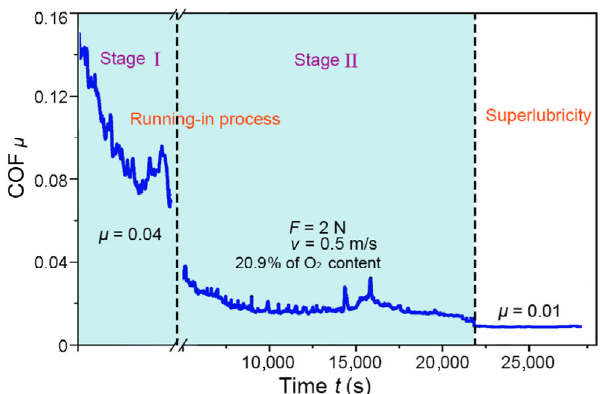
Fig. 1 COF (also denoted as μ ) vs. sliding time of the steel/steel interface lubricated with EPBD-0201 solution in a simulated air environment with ~20.9 wt% of O 2 and ~79.1 wt% of N 2 . The applied load F was 2 N, and the sliding speed v was 0.5 m/s.